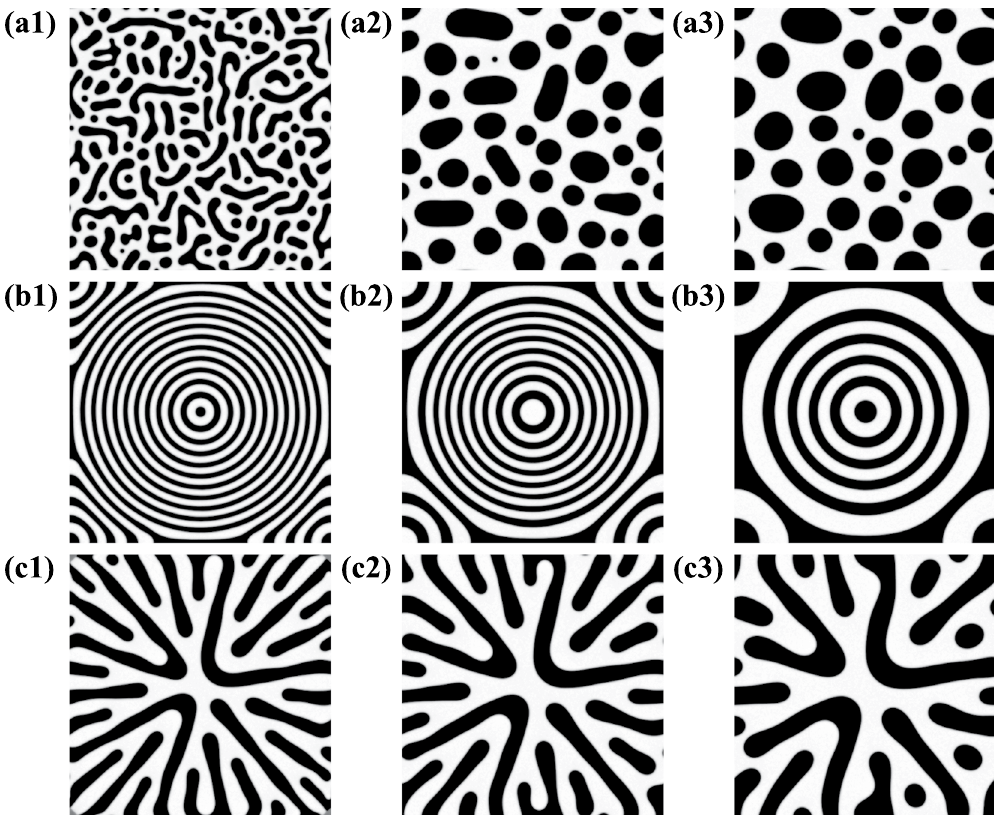
Figure 2. Time evolution of transient patterns with a single propagated trigger when φ = 0.1. ( a ) Time evolution of the random droplet pattern when v tri = 10 at t = 100 (a1), 1000 (a2) and 10000 (a3). ( b ) Time evolution of the CC pattern when v tri = 0.5 at t = 1000 (b1), 5000 (b2) and 20000 (b3). ( c ) Time evolution of the DP pattern when v tri = 0.1 at t = 4000 (c1), 8000 (c2) and 15000 (c3). All images correspond to times after the trigger has reached the end of the simulation